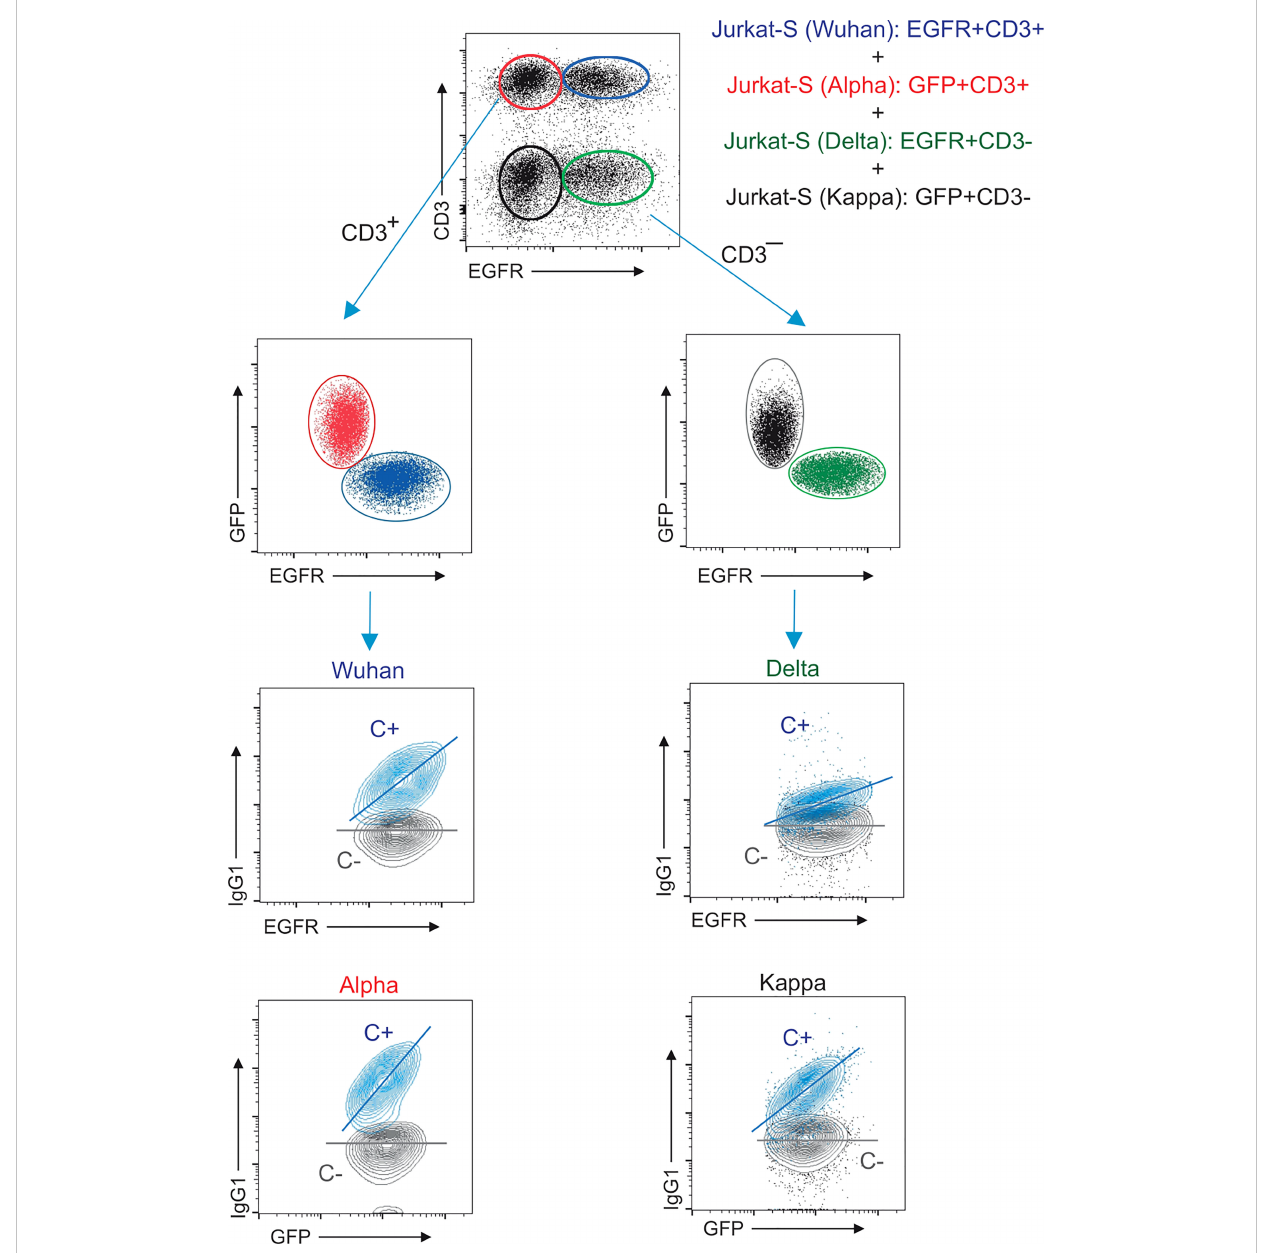
FIGURE 3 Multiplexed method to measure the reactivity of IgG1 antibodies with the S protein of the Wuhan, Alpha, Delta and Kappa variants. Gating strategy to measure binding to the Wuhan, Alpha, Delta and Kappa variants. Jurkat-S(Wuhan), Jurkat-S(Alpha), Jurkat-S(Delta) and Jurkat-S(Kappa) cells were mixed in 1:1:1:1 ratio and incubated with either a 1:50 dilution of a positive control serum (C+) from a patient of the fi rst wave in 2020 or a negative control serum (C-) obtained before the COVID-19 pandemics. Cells were subsequently incubated with mouse anti-human IgG1-PE, mouse anti- CD3-APC and mouse anti-human EGFR-BV421 antibodies. After incubation, cells were gated according to lymphocyte FSC-A and SSC-A and subsequently on 7-AAD negative cells (7-AAD+ are dead cells). Live cells were subsequently gated on the FL1 channel (for CD3+ cells) and on the FL7 channel (huEGFRt+ cells). This allowed to distinguish four populations of cells: EGFR+CD3+ (Jurkat-S[Wuhan], EGFR – CD3+ (Jurkat-S[Alpha]), EGFR+CD3 – (Jurkat-S[Delta]) and EGFR – CD3 – (Jurkat-S[Kappa]). The cells were split between CD3+ and CD3 – cells and subsequently analyzed according to EGFR and GFP expression (FL7 and FL1 channels). The four cell populations were separately analyzed for the fl uorescence intensity of anti-IgG1 (S protein, FL2) versus GFP (for Jurkat-S[Alpha] and Jurkat-S[Kappa]) and for the fl uorescence intensity of anti-IgG1 (S protein, FL2) versus EGFR (for Jurkat-S[Wuhan] and Jurkat-S[Delta]). A diagonal lane is plotted on the bicolor contour plots corresponding to the C+ staining to indicate a relationship between S protein expression and either GFP or